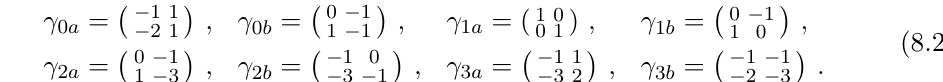
Figure 3. The real and imaginary parts of (cid:13) (cid:0) 1